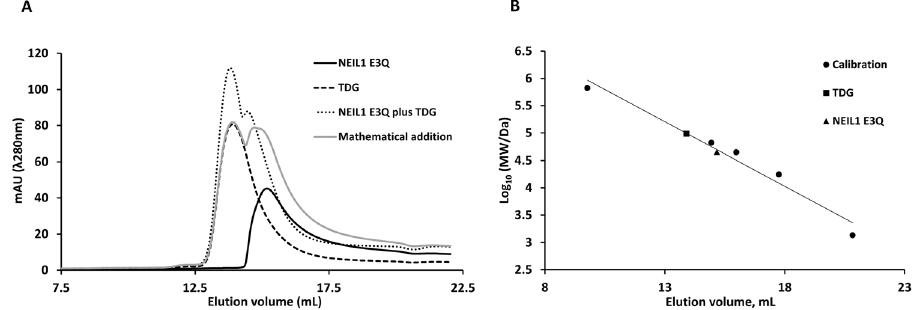
Figure 5. NEIL1 and TDG bind to each other directly: Physical interactions between NEIL1 E3Q and TDG were tested by size exclusion chromatography in SEC buffer (70 mM MOPS, pH7.5, 5% glycerol, 1 mM EDTA, 1 mM DTT and 100 mM KCl). Panel ( A ) shows the chromatograms, panel ( B ) illustrates the calibration of the column. The migration profiles of NEIL1 E3Q (black continuous line) and TDG (black dashed line) in isolation were consistent with monomeric and dimeric states, respectively (the mass of the dimer is used for the TDG data point in the calibration panel). Co-injection of the two proteins (one TDG dimer per NEIL1 monomer) led to an elution profile (grey dotted line) that was significantly different from the sum of profiles for separate injections (grey continuous line).